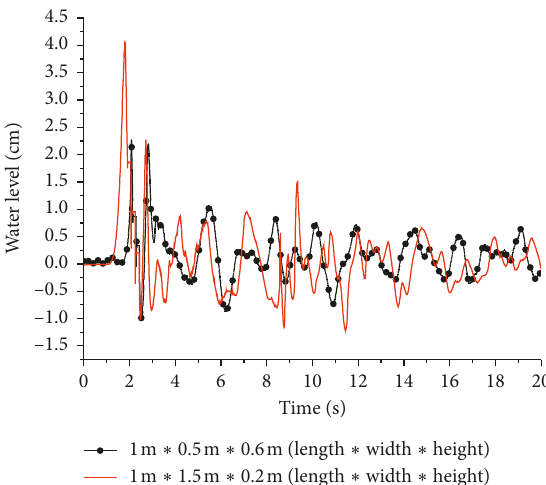
Figure 5: Comparison between Heinrich’s [36] and the experi- mental free surface at 0.6 s.